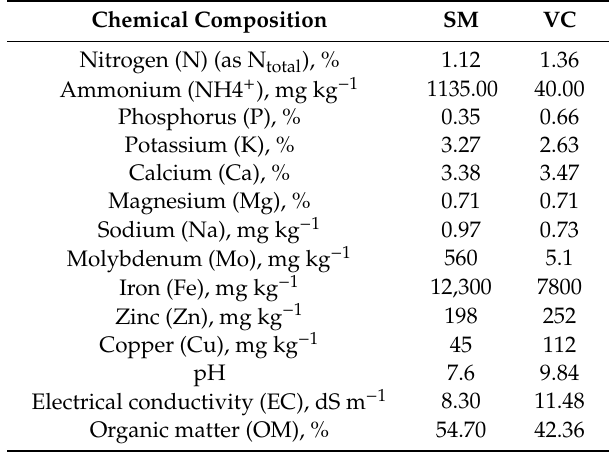
Table 1. The nutrients content of the solarized manure (SM) and vermicompost (VC).